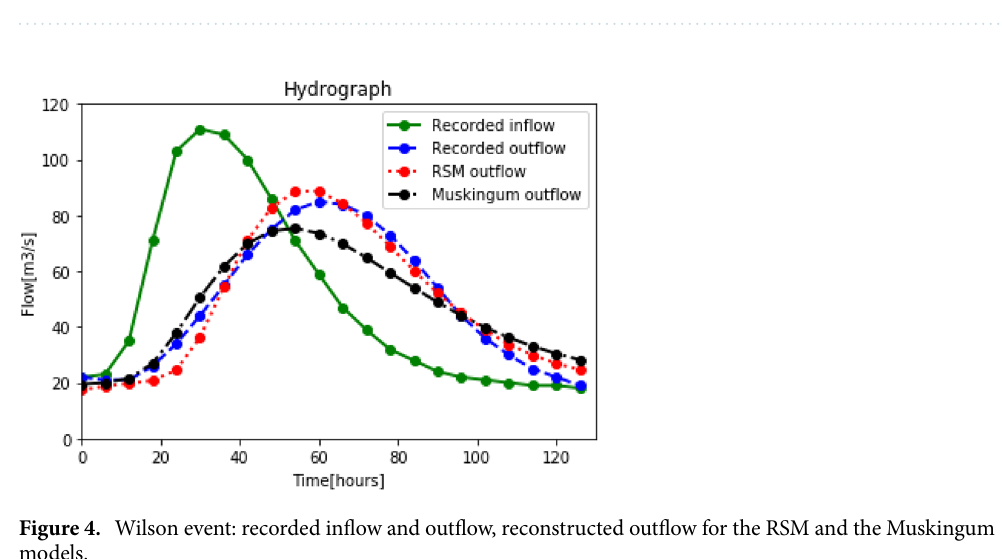
Table 1. Recorded and reconstructed outflow for the Wilson event.